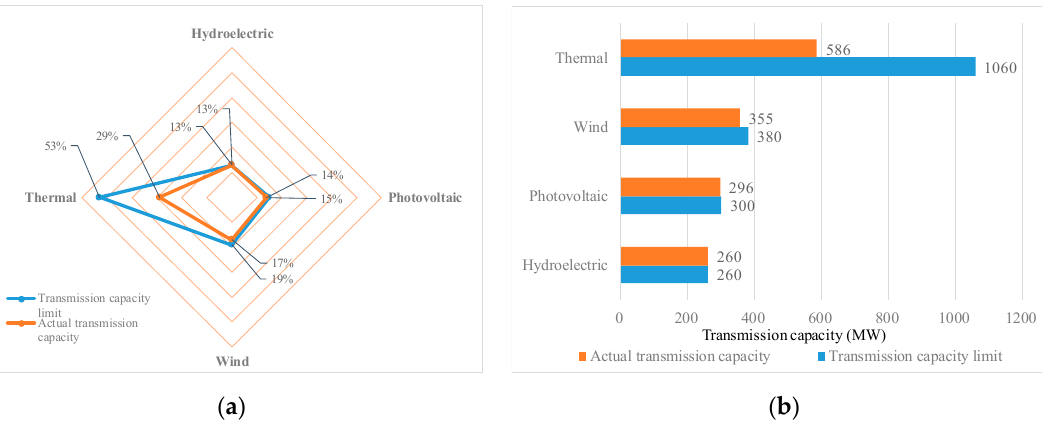
Figure 5. ( a ) Simulation results of the optimal scheme of the actual output of each energy plant; ( b ) the optimal output scheme for each power plant when the power demand is 2000 (MW).